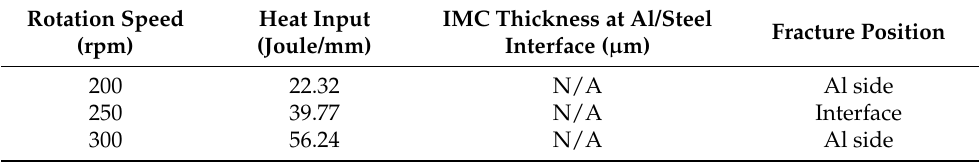
Table 4. Shows amount of heat input, IMC thickness and fracture position for each rotation